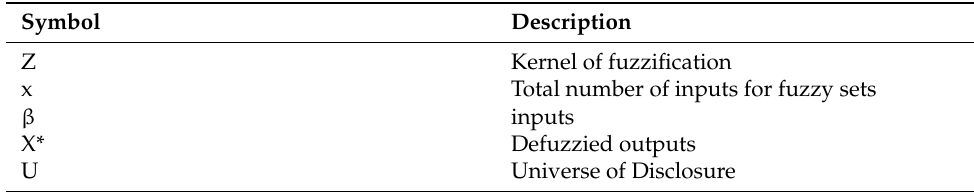
Table 1. Symbols used in paper.